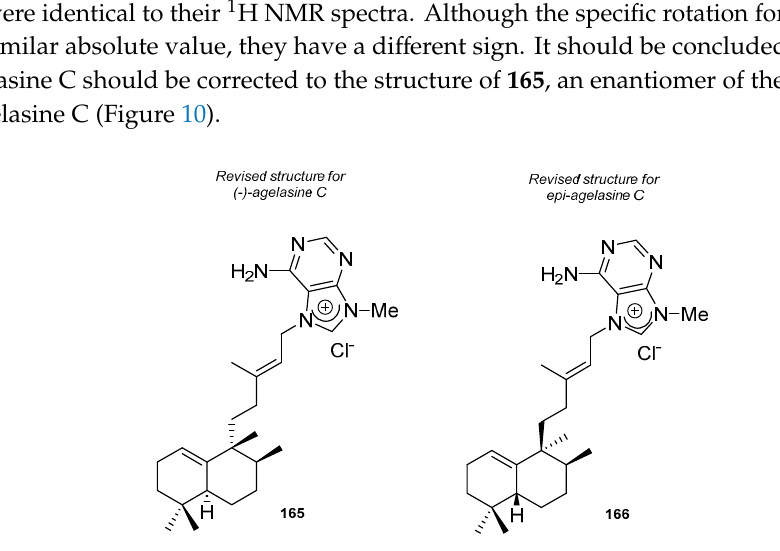
Figure 10. Revised structures for (-)-agelasine C and epi -agelasine C.